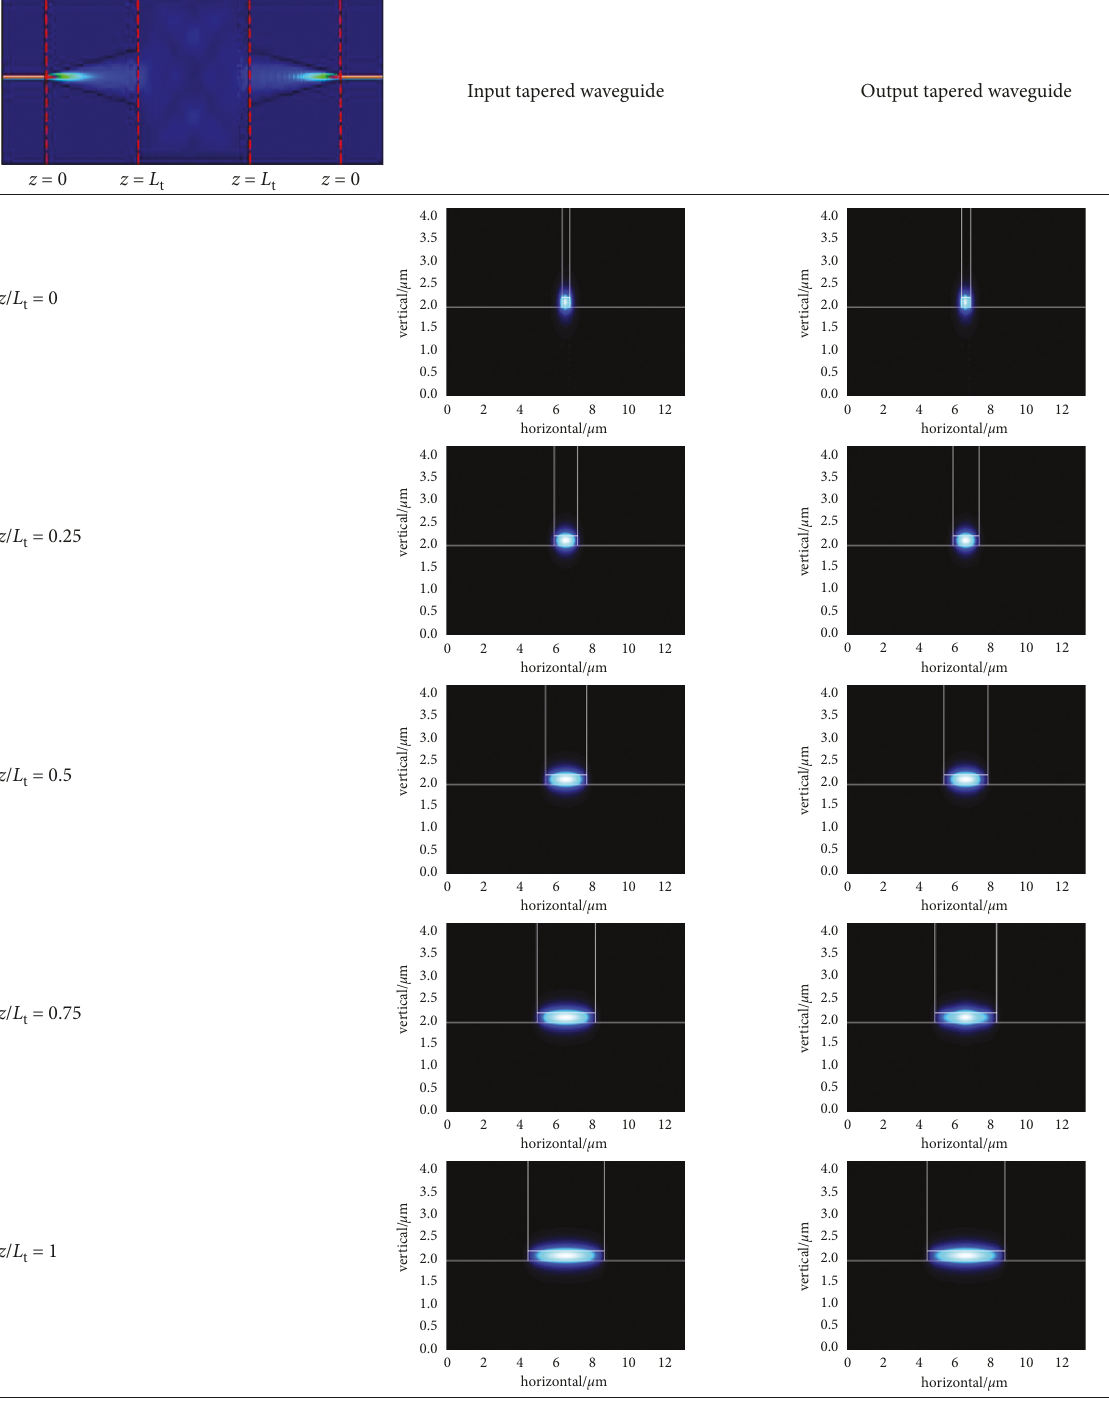
t of 4.2 μ m and